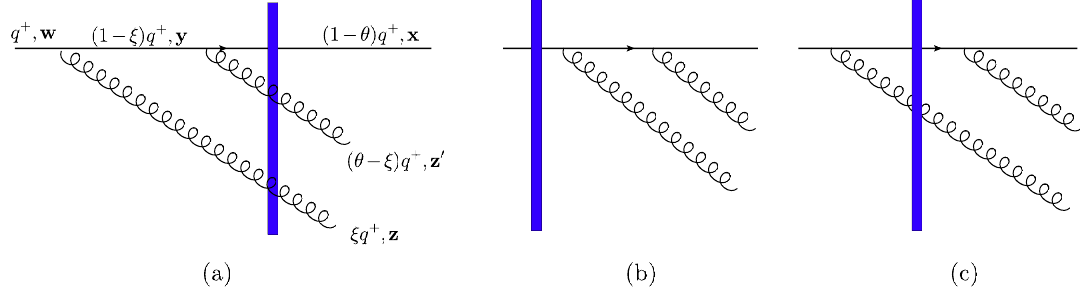
Figure 6 . The three possible configurations for the interplay between parton branching and scat- tering, for a final partonic state built with three quarks: (a) initial-state evolution (the first term in the r.h.s. of eq. (3.2)), (b) mixed evolution: the gluon is emitted prior to the scattering, but it splits after the scattering (the second term in eq. (3.2)), (c) final-state evolution (the third term in eq.